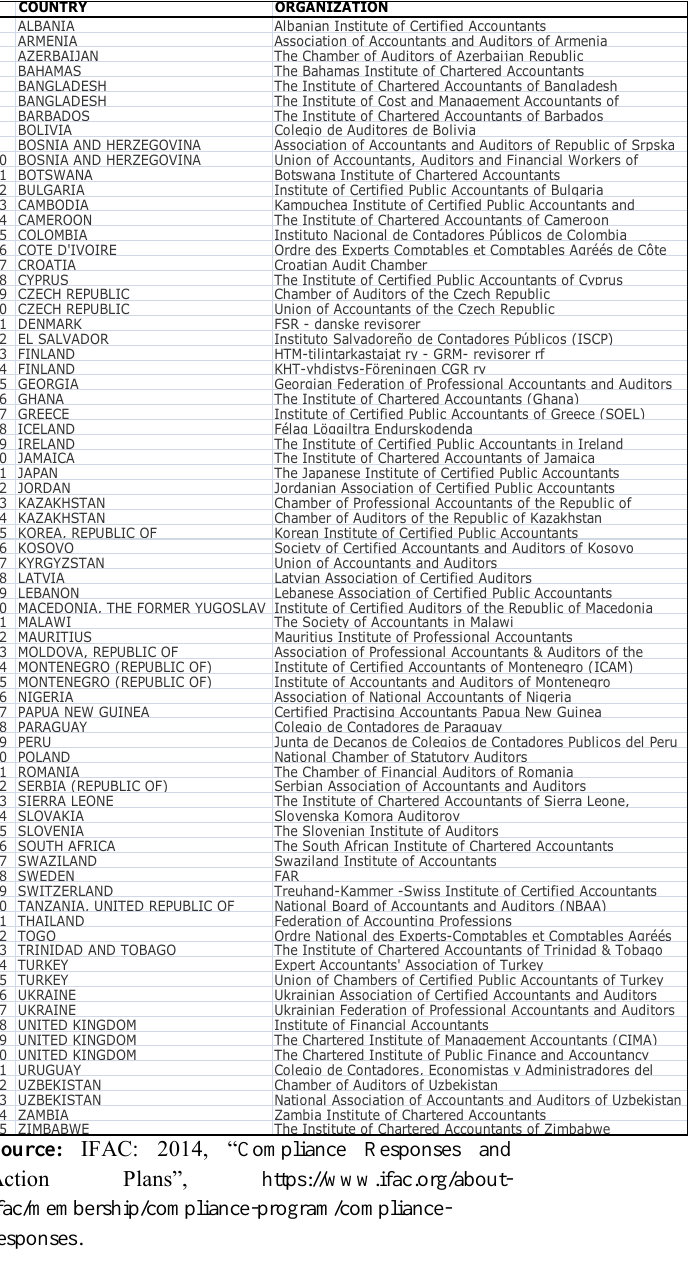
Table 1: Accounting Organizations that Completely Apply the IFAC Code of